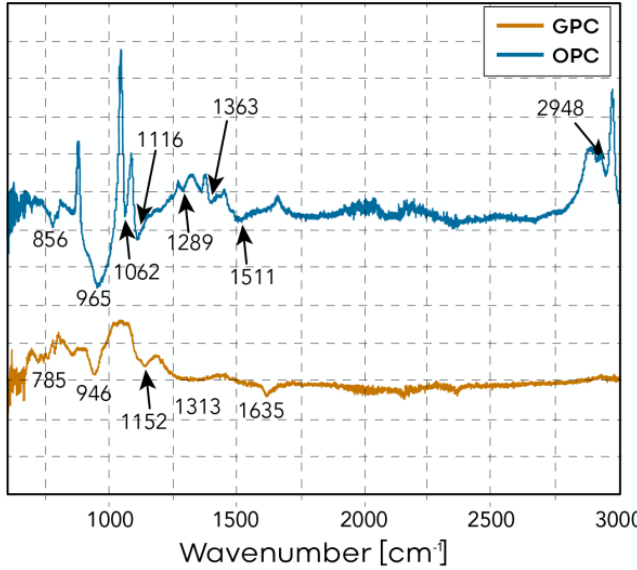
Figure 8. FT–IR peaks observed in fly-ash-based GPC and OPC samples [47,48].